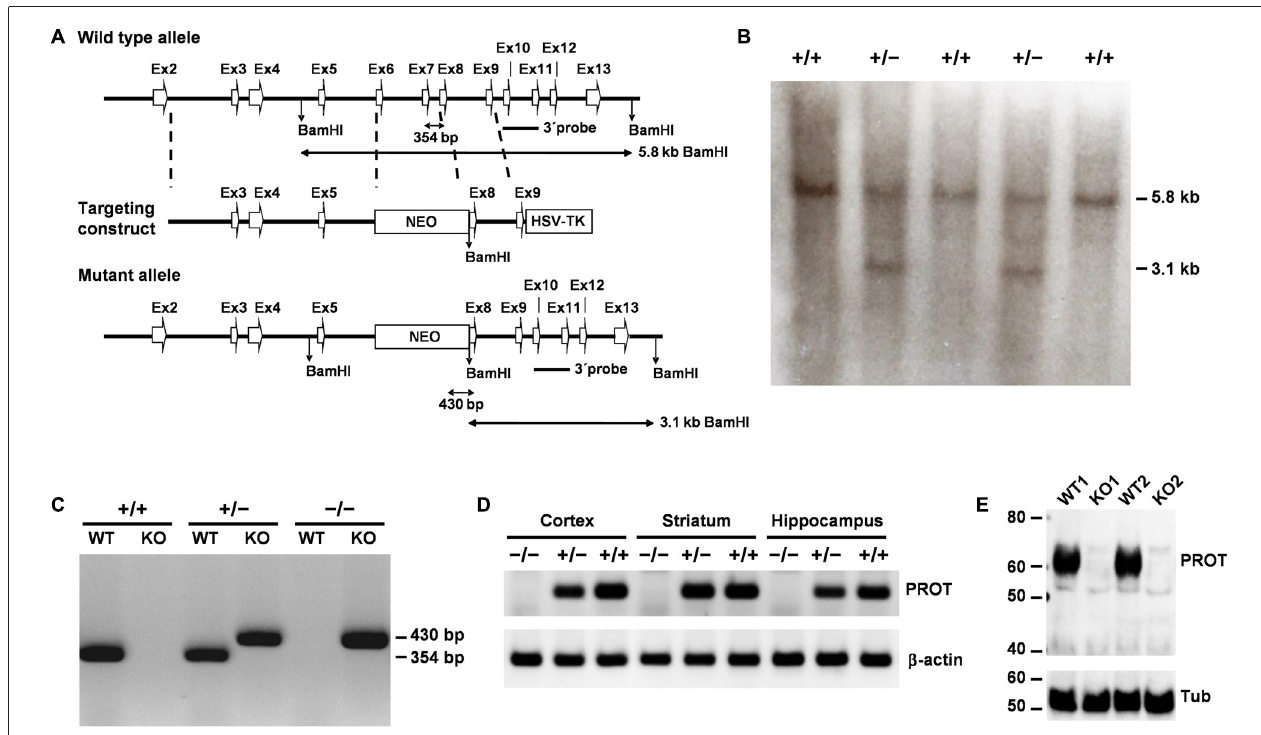
FIGURE 1 | Targeted disruption of the mouse PROT gene. (A) Knockout (KO) strategy showing the wild-type (WT) PROT locus, the targeting construct, and the targeted allele. Exons are represented as white arrow boxes. The probe used for Southern analysis, the sizes of the restriction fragments detected with this probe, and the sizes of the bands generated by PCR analysis of genomic tail DNA are indicated. (B) Southern blot analysis of DNA isolated from untargeted (+/+) and targeted (+/ − ) embryonic stem (ES) cell clones. As expected, the BamHI restriction fragment size change from 5.8 kb to 3.1 kb is seen in the targeted cells. (C) Genotyping of F2 mouse offspring using PCR analysis of genomic tail DNA. The 354- and 430-bp bands represent the WT and mutant PROT alleles, respectively. (D) Reverse transcriptase-polymerase chain reaction (RT-PCR) analysis of brain region expression of PROT and β -actin in WT (+/+), heterozygous (+/ − ), and homozygous ( − / − ) KO mice. Note the absence of PROT transcripts in homozygous animals. (E) Western blot analysis of cortex membrane fractions from different animals using the PROT antibody and, after stripping, reprobed with the β -tubulin antibody. Note that PROT protein expression is abolished in the homozygous mutant